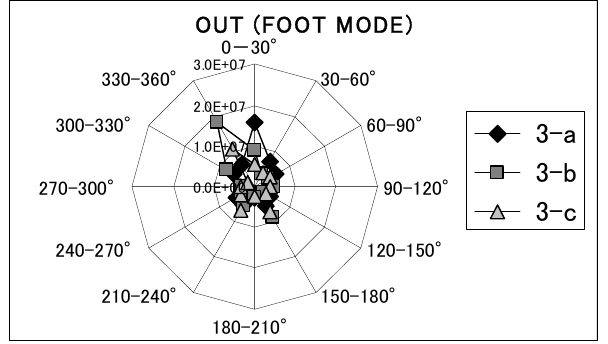
Fig. 16 Distributions of the interval RMS value of static pressure fluctuation (at the outlet of blade, FOOT MODE). The unit is [mV/s 2